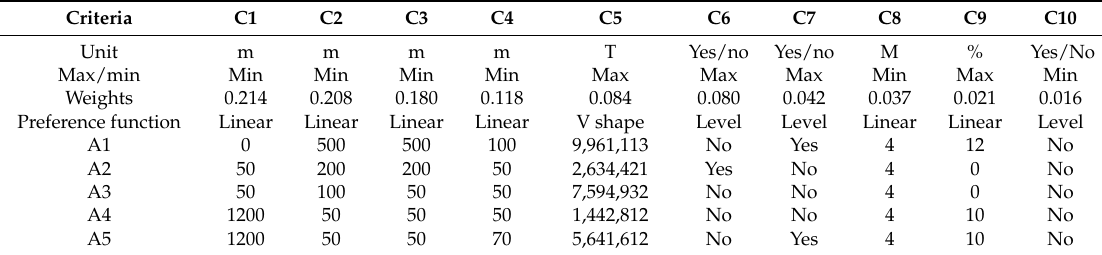
Table 10. Quantified matrix of decision making (Evaluation matrix).